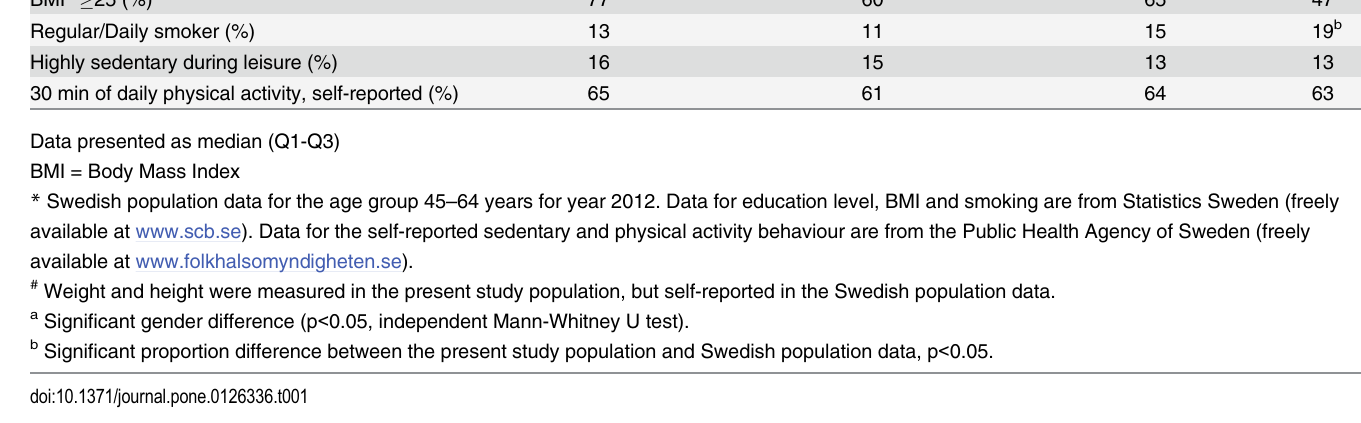
* Swedish population data for the age group 45 – 64 years for year 2012. Data for education level, BMI and smoking are from Statistics Sweden (freely available at www.scb.se). Data for the self-reported sedentary and physical activity behaviour are from the Public Health Agency of Sweden